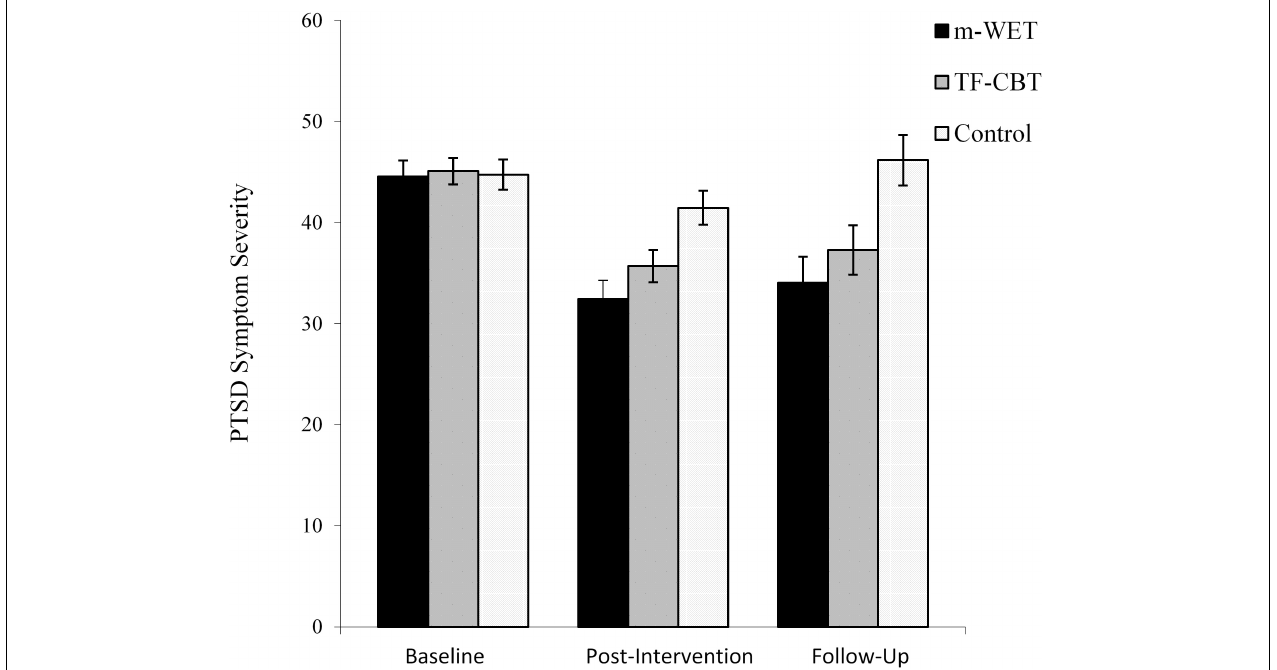
FIGURE 3 | Depicting posttraumatic stress (PTSD) symptom severity at baseline, post-intervention and 3-month follow-up for the modified- Written Exposure Therapy (m-WET), trauma-focused-cognitive behavior therapy (TF-CBT), and control groups.